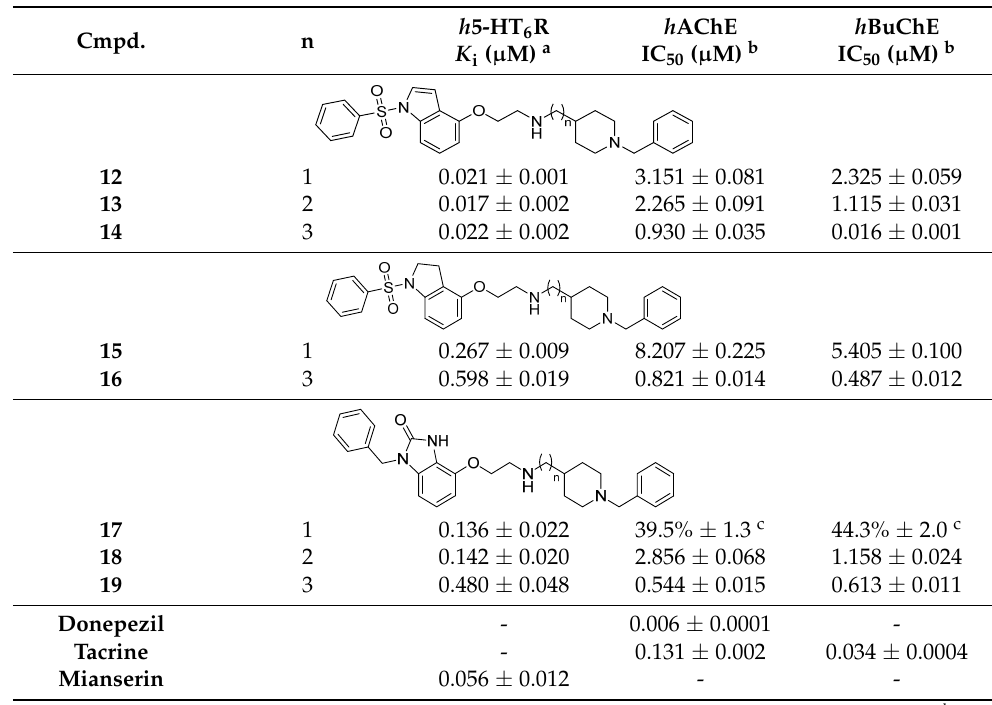
a K i values are expressed as the mean ± standard error of the mean (SEM) of at least three experiments. c % of inhibition of the enzymes observed at 10 µ M concentration of 17 . h 5-HT 6 R-recombinant human 5-HT 6 receptors, h AChE-human recombinant AChE, h BuChE-human recombinant BuChE.